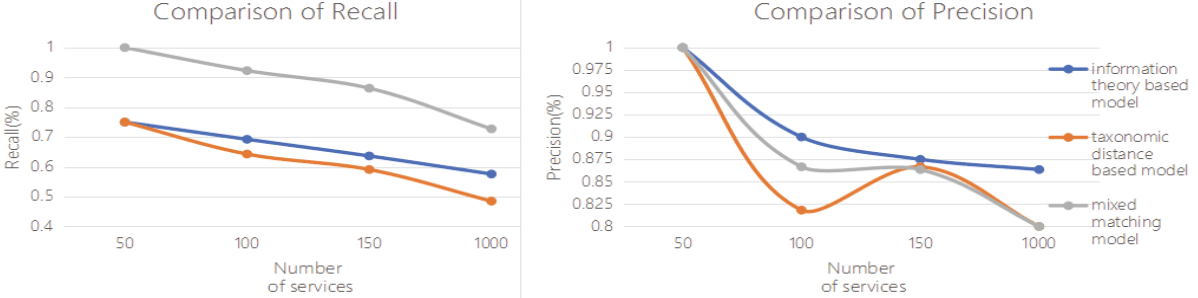
Figure 5: Performance comparison when 𝜃 = 0.7.